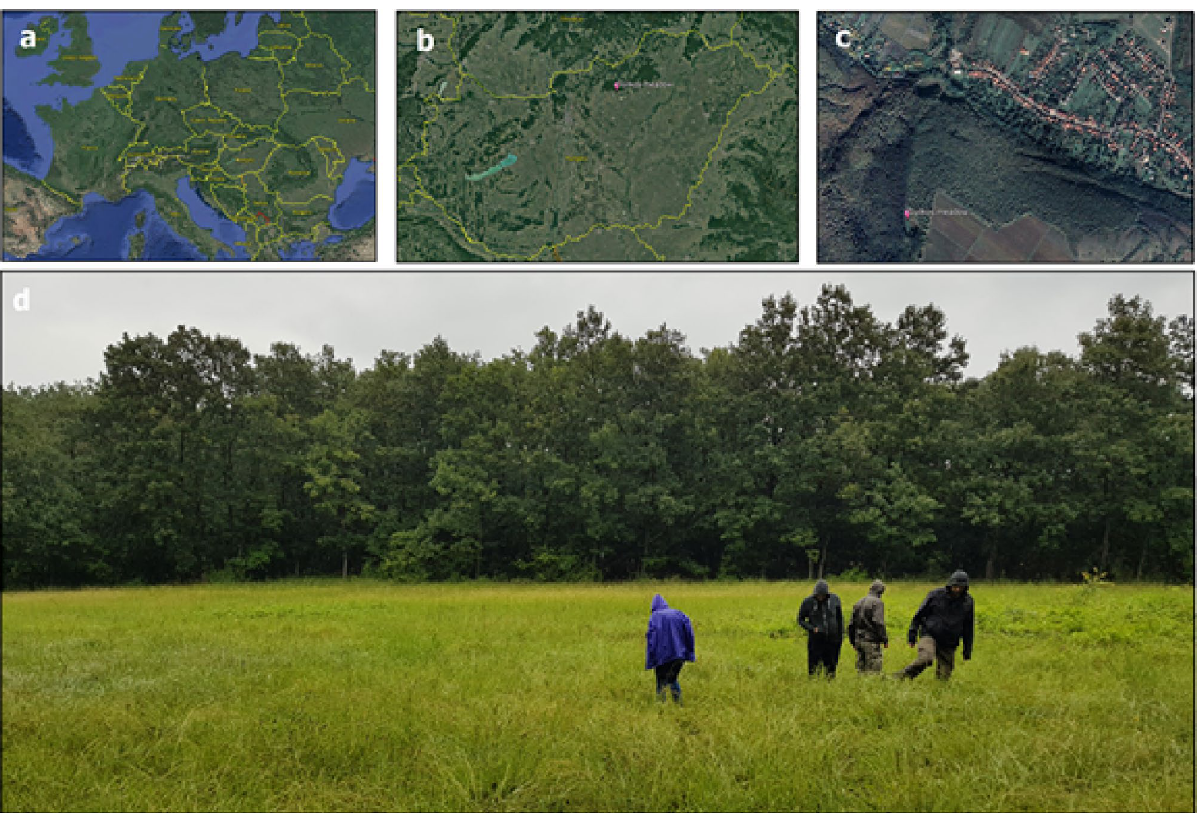
Figure 5. The field site where M. scabrinodis workers for our study were collected. Field site is located in Europe ( a ), Hungary ( b ) near Pálosvörösmart ( c ). Wet meadow (Gyilkos-rét) surrounded by deciduous forest ( d ) Figure is created by using Google Earth Pro ver. 7.3.3.7786 (https:// www. google. hu/ intl/ hu/ earth/ versi ons/# earth- pro) and Microsoft Paint ver. 2004 (https:// suppo rt. micro soft. com/ hu- hu/ windo ws/a- micro soft- paint- megny it%